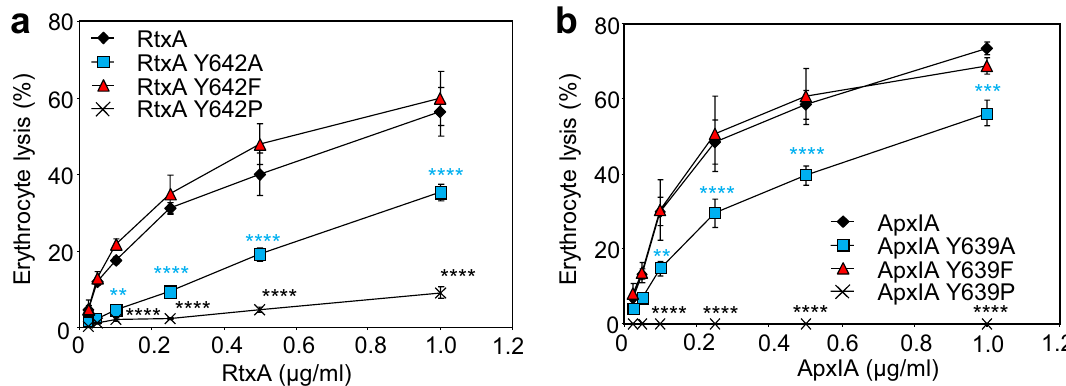
Figure 7. The aromatic ring of the conserved tyrosine is essential for the full hemolytic activity of RtxA and ApxIA. The hemolytic activity of RtxA ( a ) and ApxIA ( b ) was analyzed as described in Fig. 4. Each point represents the mean ± SD of three independent determinations performed in duplicate with two independent toxin preparations. Significant differences are indicated by asterisks (** p < 0.01; *** p < 0.001; **** p <